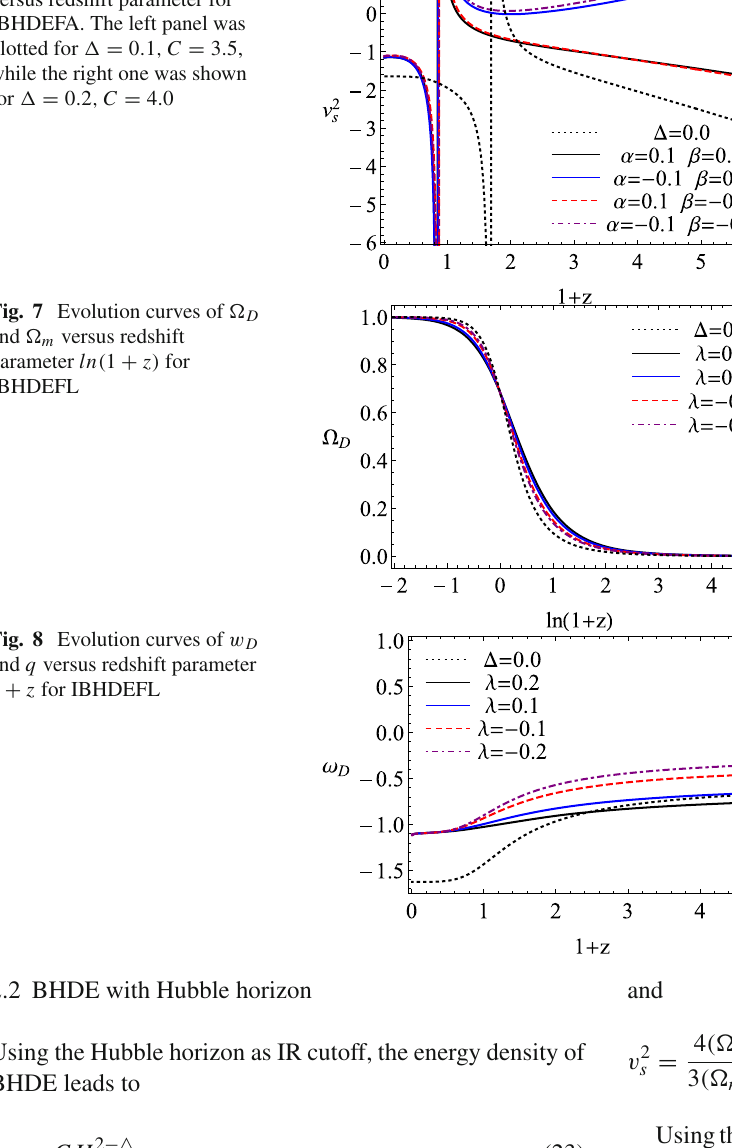
Fig. 6 Evolution curves of v 2 s versus redshift parameter for IBHDEFA. The left panel was plotted for (cid:5) = 0 . 1 , C = 3 . 5, while the right one was shown for (cid:5) = 0 . 2 , C = 4 . 0